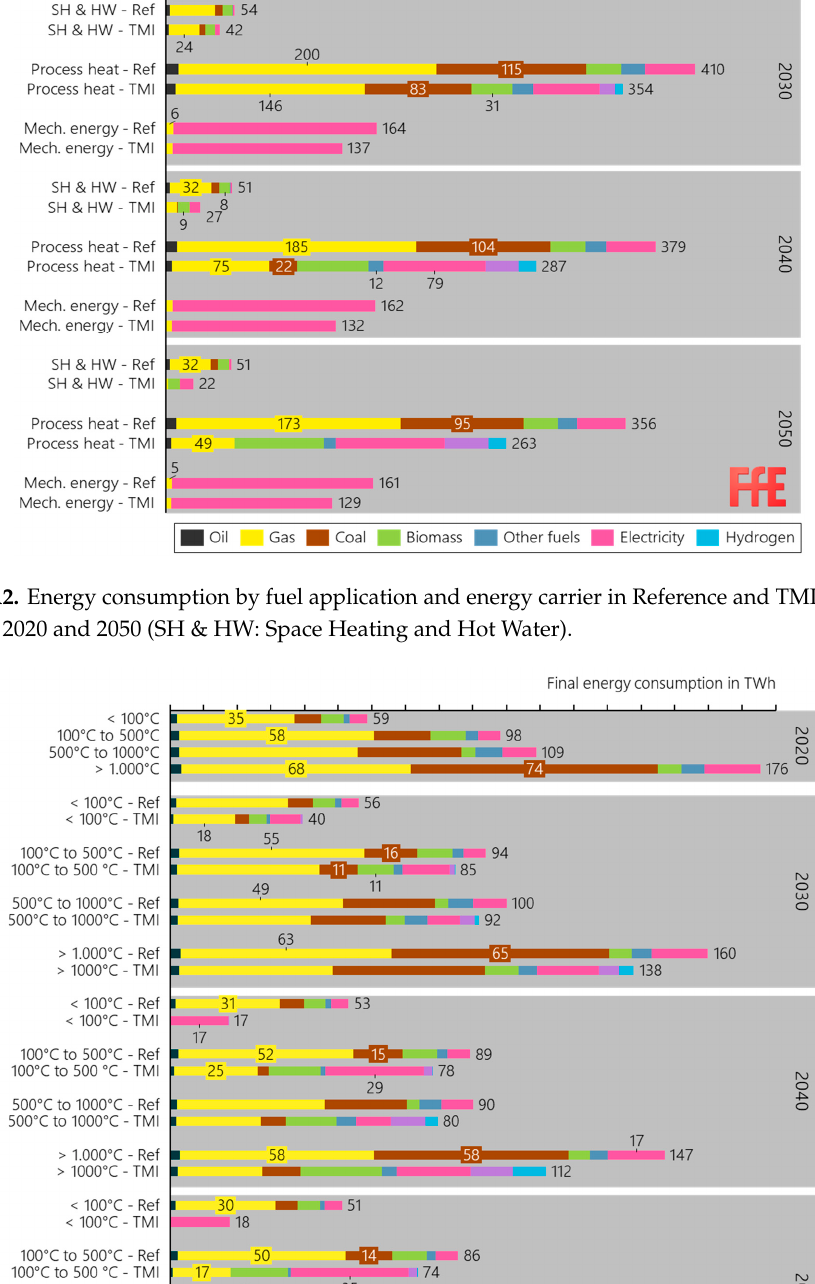
Figure A4. Energy and process-related emissions in the Reference (left) and TMI scenarios between 2020 and 2050.